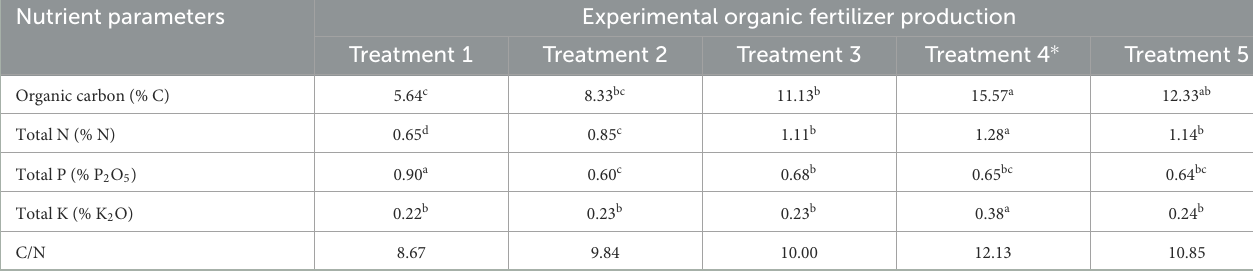
TABLE 3 Chemical composition of organic fertilizer production. Nutrient